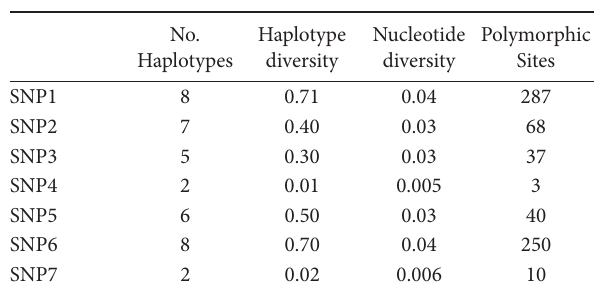
Table 2. Genetic diversity parameters determined in the studied SNPs.